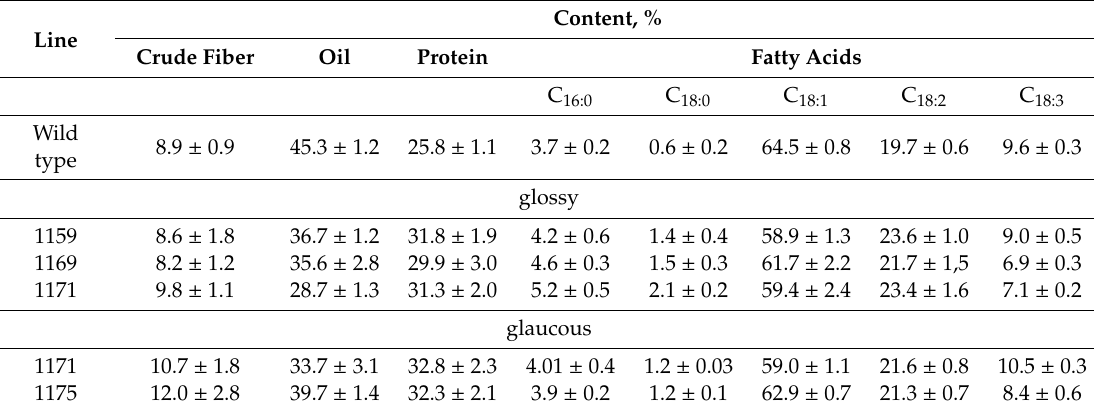
Table 4. Content of sinapine and sinapic acid (mg 100 g − 1 ) in seeds of WT and glossy plants. Substance Table 5. The content of fiber, protein, oil, and essential fatty acids in the seeds of WT plants and M 5 mutant